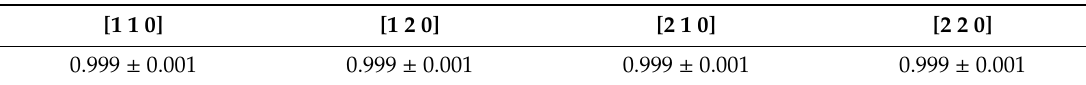
Table 2. Mean and standard deviation of the Pearson correlation coe ffi cient obtained when comparing the first and second orders time-invariant models with no delay ([ n a n b 0 ]) output and each one of the weight curves collected for the 32 participants in the